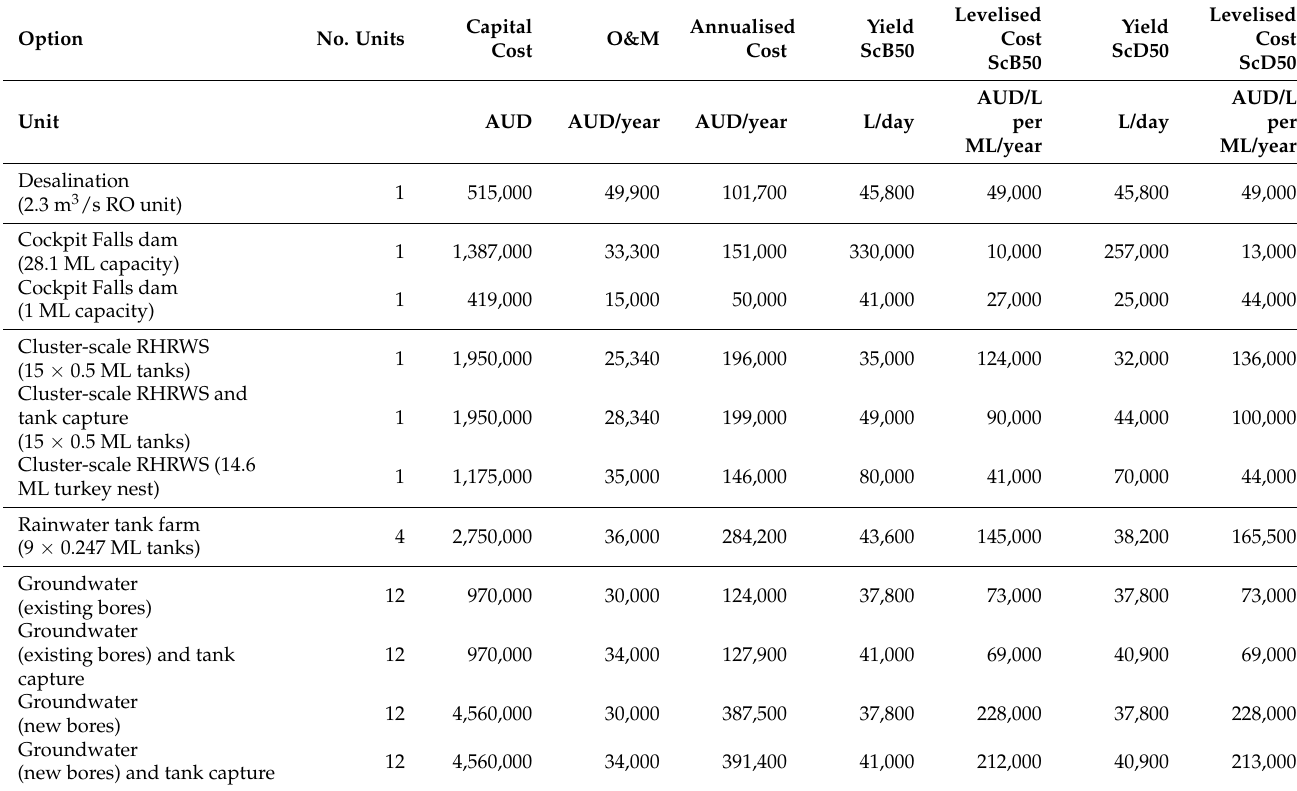
Table 5. Centralised management intervention options under Scenario B50. Yield is the quantity of water that can be supplied at 100% reliability between 1 January and 31 March. Levelised cost is the annualised cost divided by the mean annual quantity of water supplied over the 50-year historical baseline and future climate